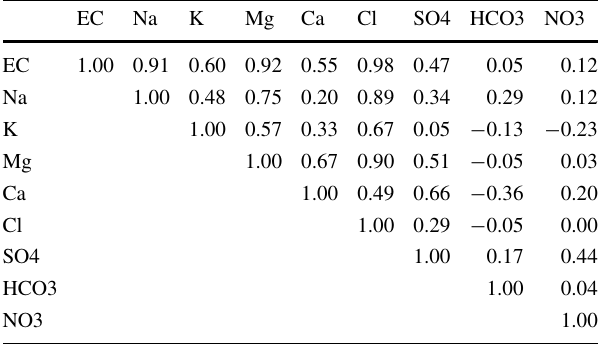
Table 5 Correlation coefficients of physicochemical parameters of well groundwater